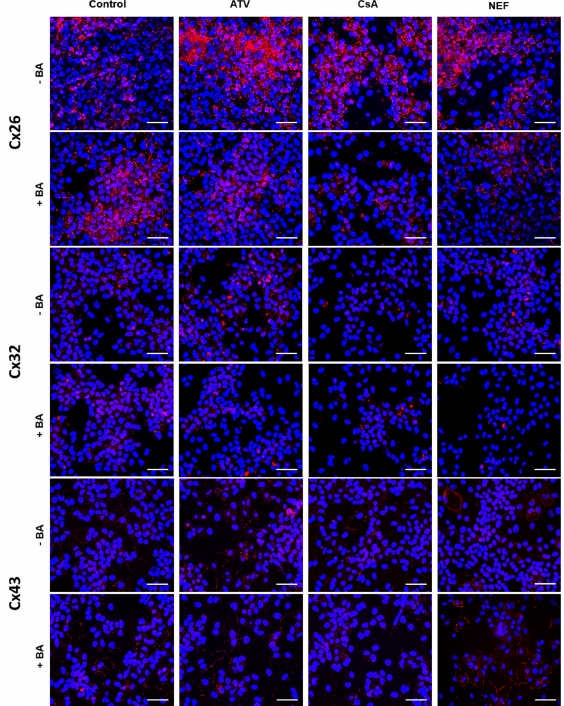
Figure 6. Connexin protein localization in human hepatoma HepaRG cells cultured in cholestatic conditions. Human hepatoma HepaRG cells were exposed to cholestatic drugs either in the absence or presence of a 50 × concentrated mixture of bile acids (BA) for 72 h and compared to untreated human hepatoma HepaRG cells, indicated in the figure as control. Cellular localization of the three connexin species, namely Cx26, Cx32 and Cx43 (red), was revealed by immunocytochemistry analysis with nuclear counterstaining using DAPI (blue). Scale bar, 50 µ m; samples (control n = 3; control BA n = 3; ATV n = 3; ATV BA n = 3; CsA n = 3; CsA BA n = 3; NEF n = 3; NEF BA n = 3) (N =